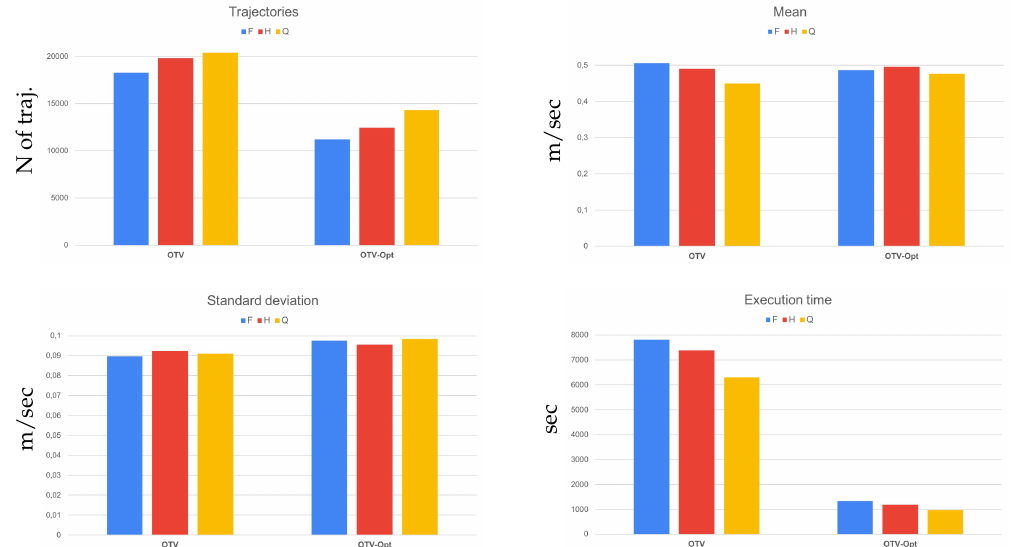
Figure 6. Comparison between the original OTV algorithm and its optimized counterpart obtained by the functional analysis at three resolutions on a sequence acquired on the Brenta river. ( Top-left ) Estimated trajectories, ( Top-Right ) average velocity, ( Bottom-Left ) standard deviation of velocity, ( Bottom-Right ) overall execution time on the Raspberry PI 3B without additional